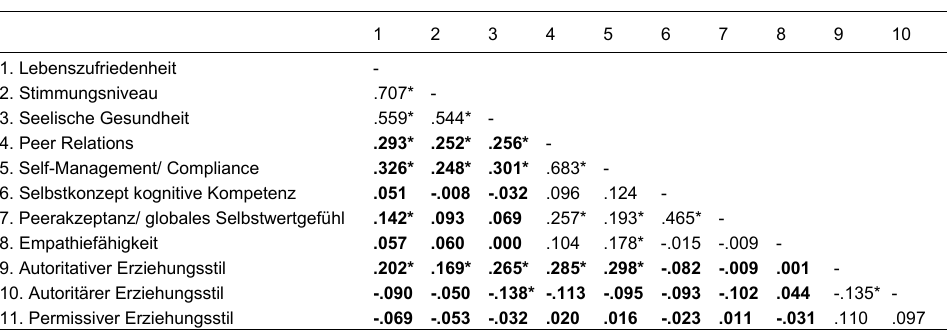
Tabelle 4 : Produkt-Moment-Korrelationen zwischen Wohlbefinden der Mutter, sozial- emotionalen Kompetenzen des Kindes und